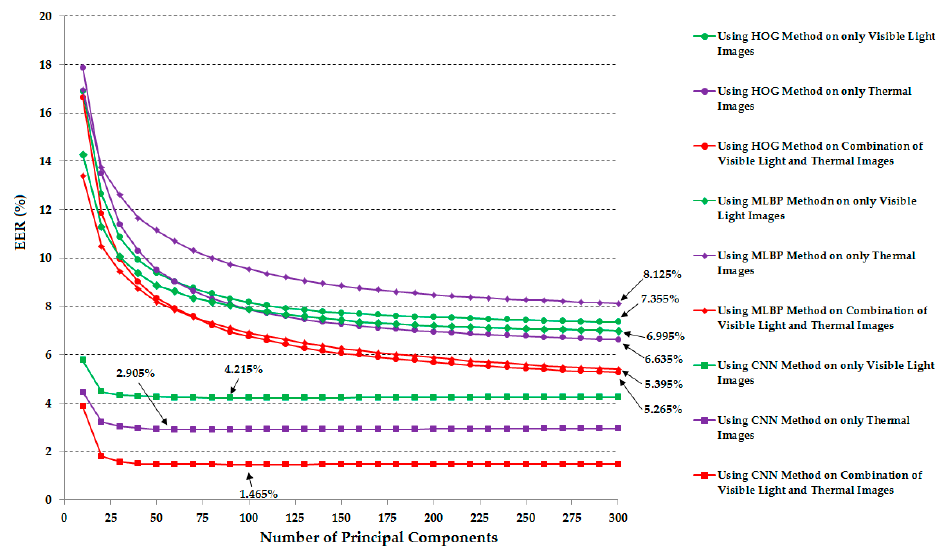
Figure 14. Verification accuracy (EER) of the recognition systems using correlation distance according to the number of principal components in PCA.